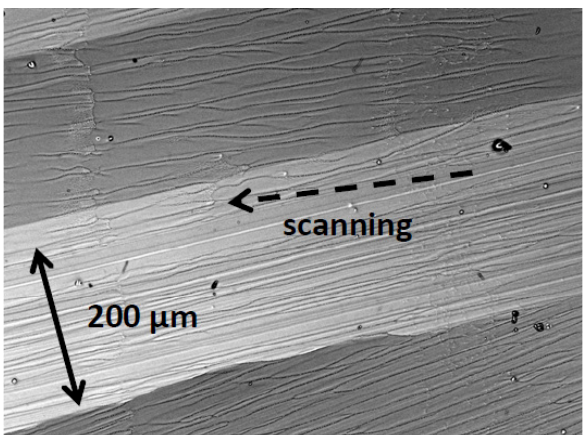
Fig. 1. Backscatter SEM image of lateral grains in diode laser crystallised Si film. ∼ 200 μ m-wide linear grains are shown in the same shade of grey; wavy lines within each grain are surface texture developed during crystallisation while straight parallel lines are twin boundaries.